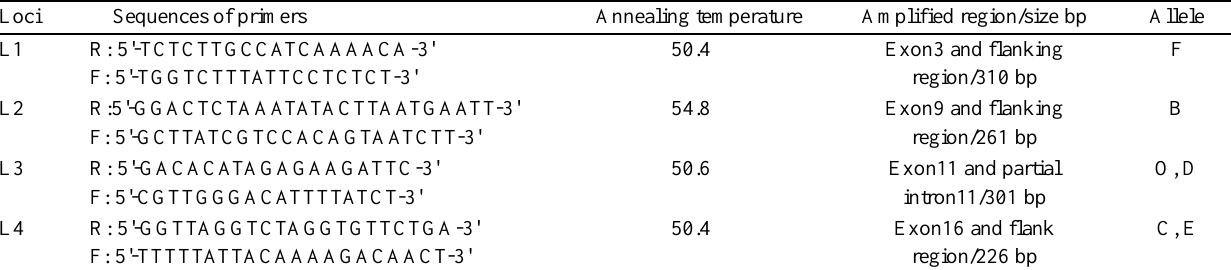
Table 1. The primer pair sequences and their information of CSN1S2 g ene in goat Loci Sequences of